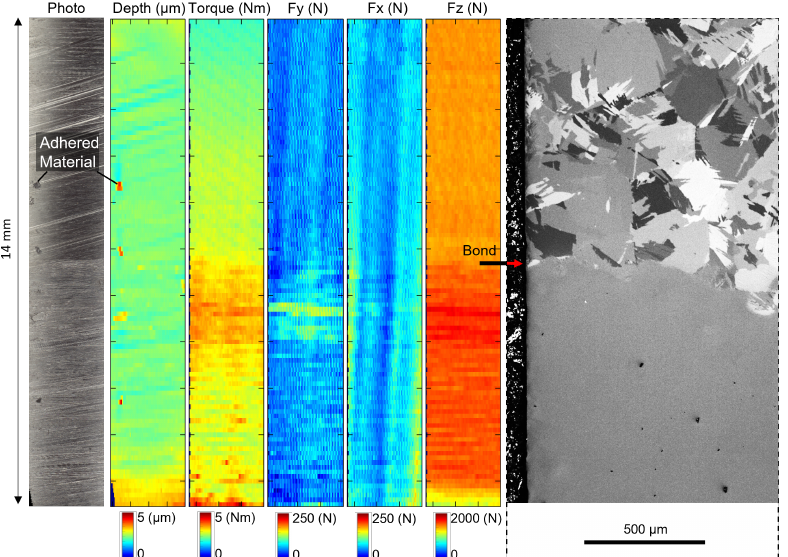
Figure 3. A photograph of the drilled surface, micrographs of the bond interfaces and depth, torque, Fy, Fx and Fz maps for holes drilled at 1845 RPM and F rev = 0.131 mm/rev in the Ti-64-Beta C workpiece (two alloy